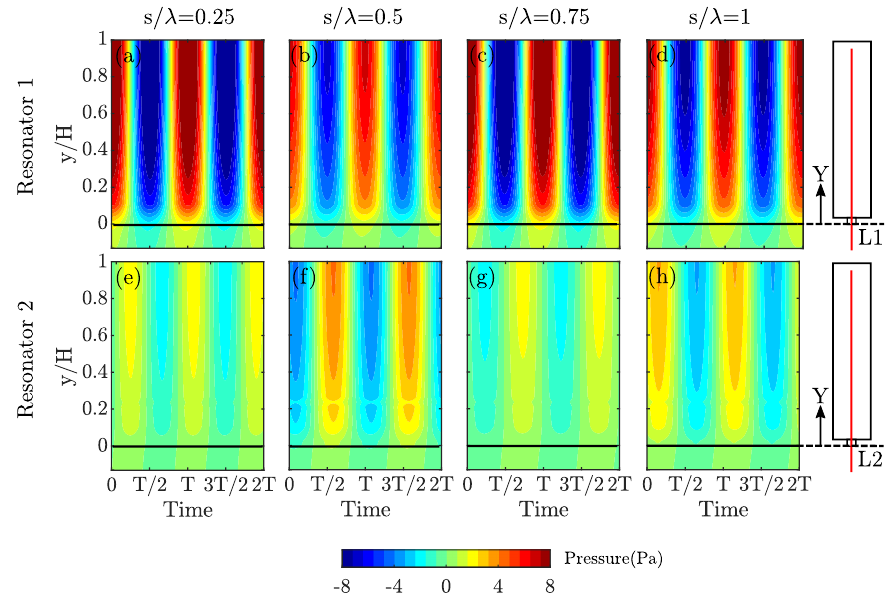
Figure 8. Contour plots of pressure inside the resonators for different spacing configurations between 0.25 < s / λ < 1. Top row: Sound pressure field within the first resonator for ( a ) s / λ = 0.25; ( b ) s / λ = 0.5; ( c ) s / λ = 0.75; ( d ) s / λ = 1; Bottom row: Sound pressure field within the second resonator for ( e ) s / λ = 0.25; ( f ) s / λ = 0.5; ( g ) s / λ = 0.75; ( h ) s / λ = 1.